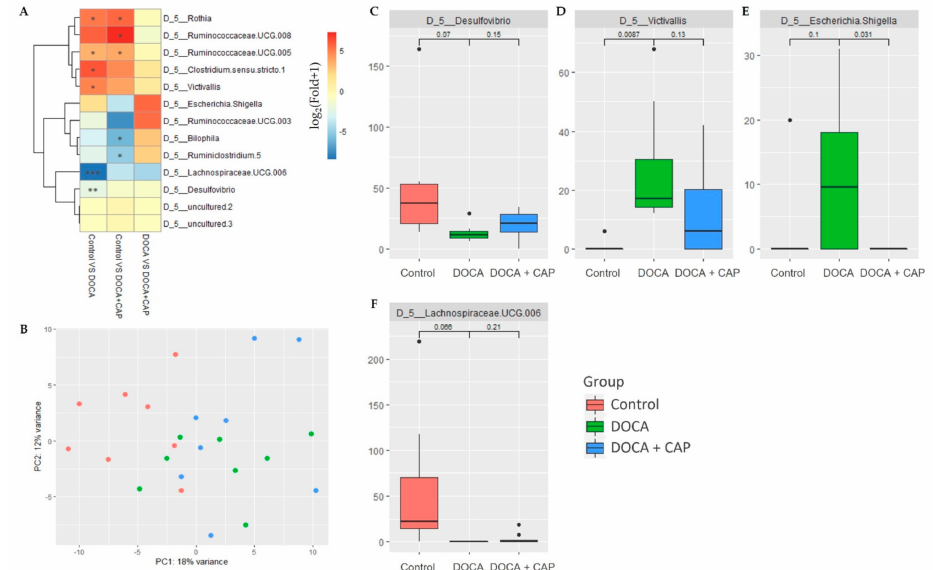
Figure 5. ( A ) Heatmap of the log-fold-change of the top 13 genus having differential abundance among the Control, DOCA, and DOCA + Captopril groups. ( B ) The plot of the first 2 principal components (PCs) of the identified bacterial genera’s abundance, with the first PC explaining 18% variance and the second PC explaining 12% variance. ( C – F ) Box plots show the abundance of the 4 highlighted bacterial genera, and the p -values of pairwise comparison are reported. (* p < 0.05, ** p < 0.01, *** p <